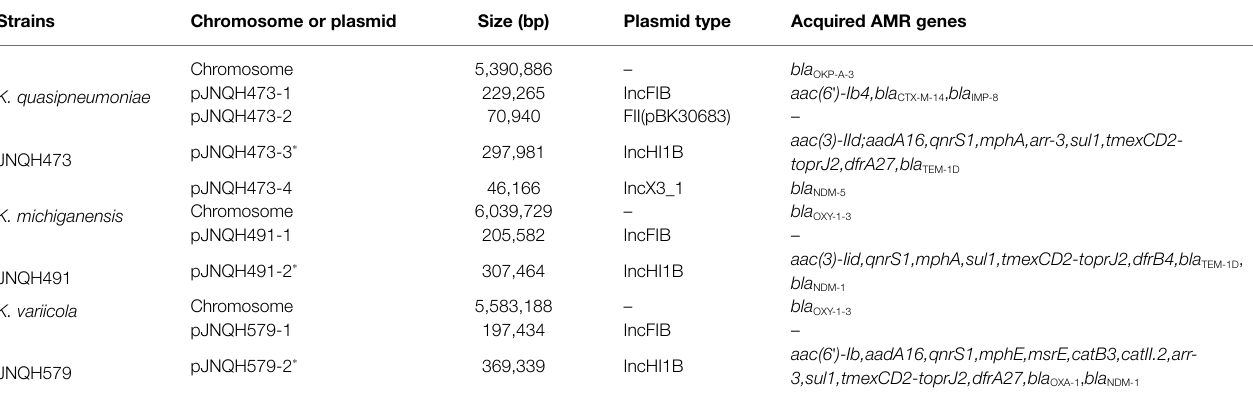
TABLE 3 | Chromosome and plasmid features of strains in this